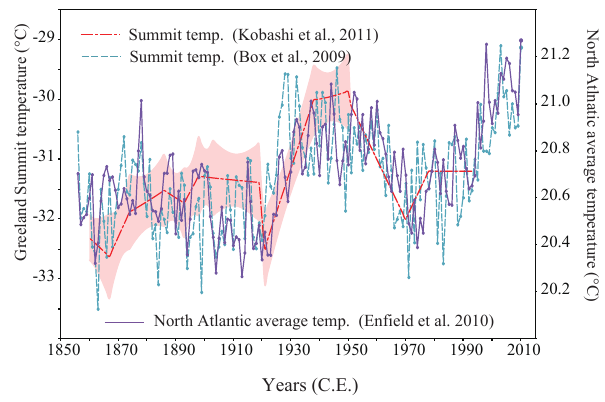
Fig. 3. North Atlantic average temperatures and Greenland Summit temperatures. Error band (red) is 1 σ (Kobashi et al., 2011). The Summit temperature by Box et al. (2009) was shifted by − 1.75 ◦ C to account for the surface-air temperature difference (Kobashi et al.,